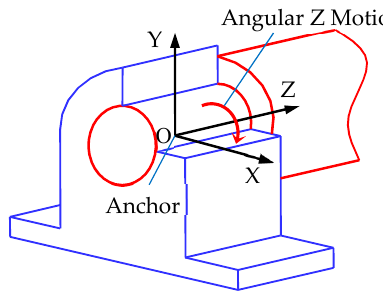
Figure 1. Schematic diagram of the revolute joint.